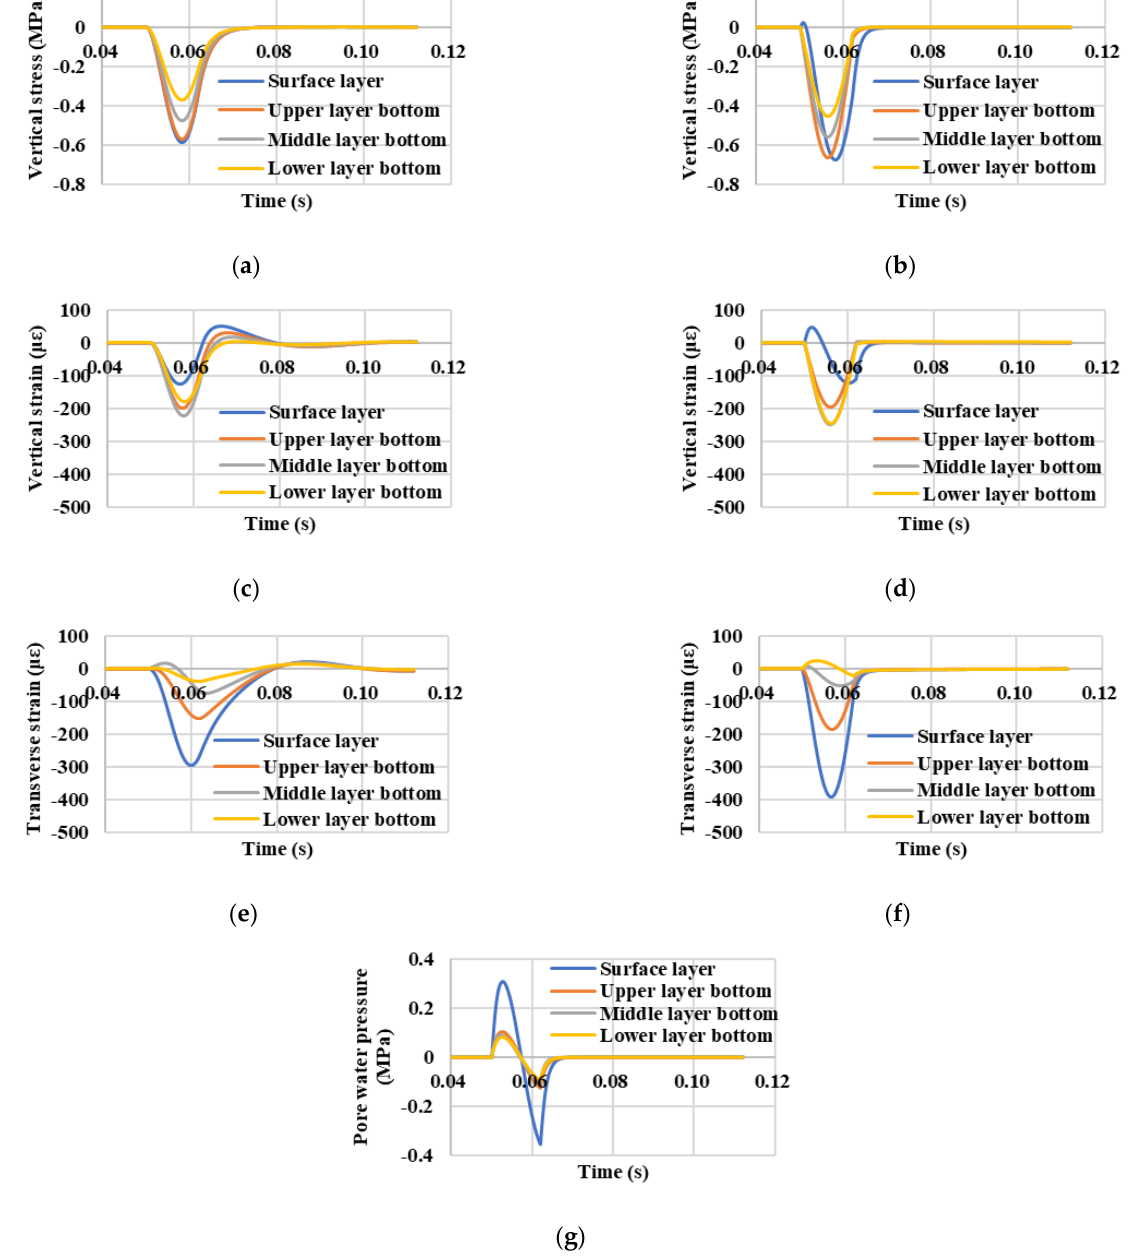
Figure 7. Time – history curves of dynamic response indicators for asphalt pavement in dry and sat- urated conditions: ( a ) Vertical stress, dry; ( b ) Vertical stress, saturated; ( c ) Vertical strain, dry; ( d ) Vertical strain, saturated; ( e ) Transverse strain, dry; ( f ) Transverse strain, saturated; ( g ) Pore water pressure, saturated.